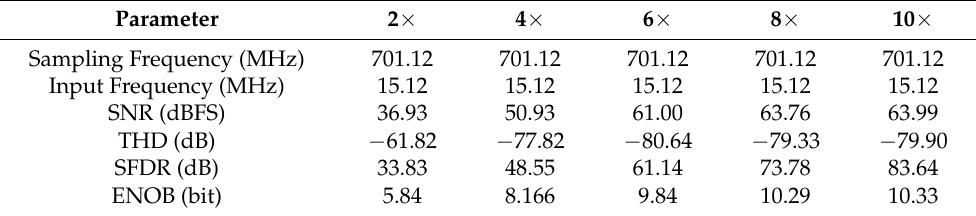
Table 3. Performance comparison of different filter coefficients with interpolation multiplier of